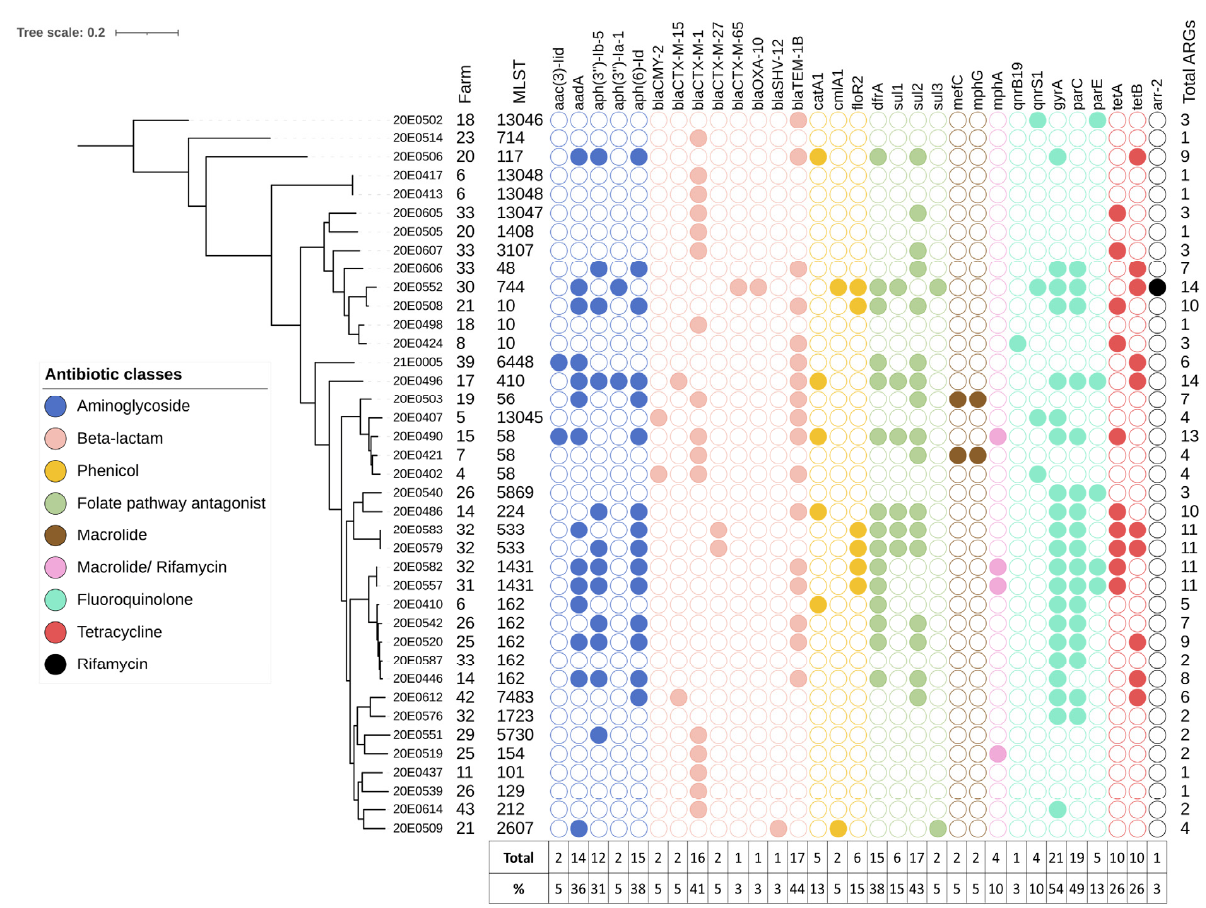
Figure 3. Whole-genome phylogenetic tree showing the distribution of the resistome of the 39 E. coli strains isolated from SAC and whole-genome sequenced. The strain designation, farm ID and MLST of the samples are indicated in the first three columns. Resistance genes, grouped by antibiotic class, are demarcated by colored circles. The last column indicates the total number of resistance genes per sample. The table below the plot shows the representation of the resistance gene, which contains the total number of each resistance gene detected in the sample and its percentage in all strains. The image was generated with ITOL (v.6).